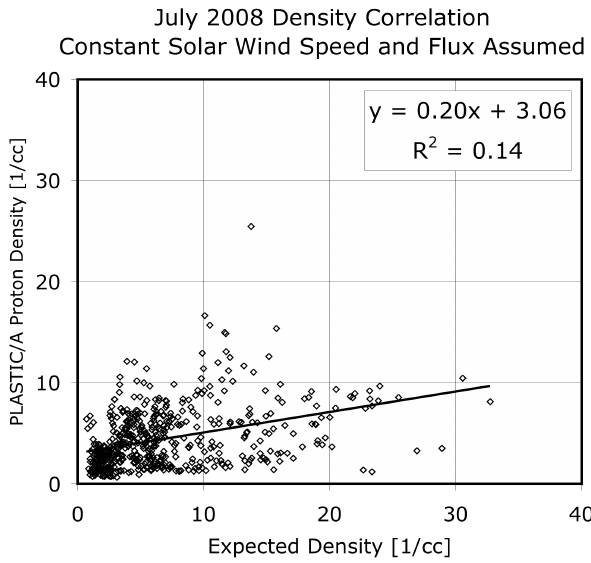
Fig. 8. Solar wind proton density correlation between PLAS- TIC/AHEAD and PLASTIC/BEHIND for July